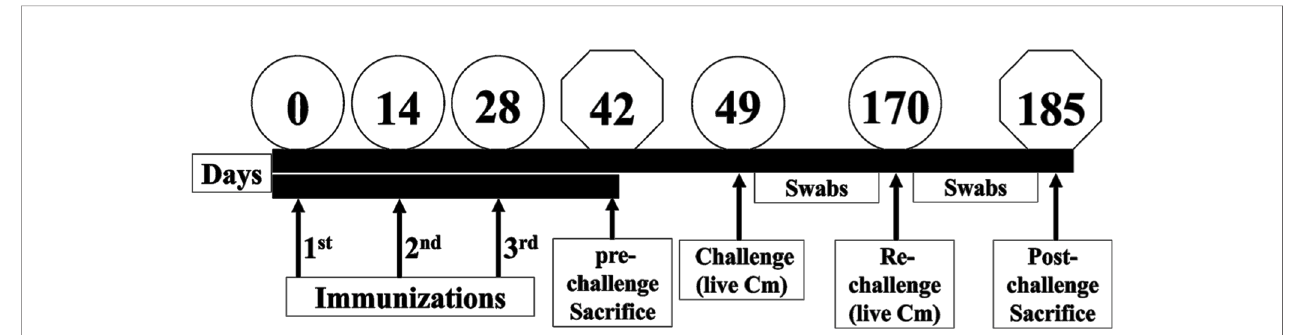
FIGURE 1 | Schematic of mice immunization and challenge studies. Three groups of female BALB/c mice were immunized three times (Days 0, 14 and 28) with either PBS or with 50 µg of PLGA-rMOMP via the SC or IN routes. Mice from each group were sacri fi ced on day 42 (pre-challenge sacri fi ce). The remaining